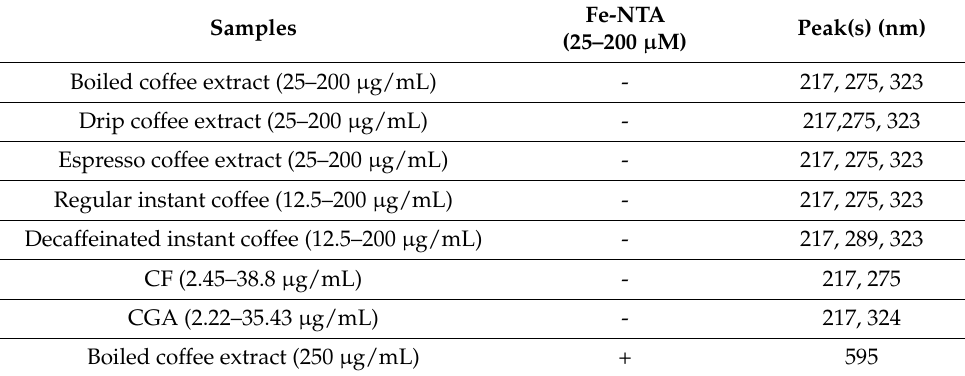
Figure 5. Spectral patterns of roasted coffee extracts, instant coffee, CF and CGA with and without the addition of iron. ( A – G ) Boiled, drip and espresso roasted coffee extracts (25–200 µ g/mL), regular and decaffeinated instant coffee (12.5–200 µ g/mL each), CF (2.45–38.8 µ g/mL) and CGA (2.22–35.43 µ g/mL) were photometrically measured at a wave- length rank of 200–800 nm against the reagent blank. ( H – N ) The coffee extracts and the instant coffees (250 µ g/mL), CF (500 µ M) and CGA (250 µ M) were incubated with Fe-NTA (25–200 µ M) for 1 h and photometrically measured at a wave- length rank of 200–800 nm against the coffee extract, instant coffee, CF and CGA solutions. Abbreviations: CF = caffeine, CGA = chlorogenic acid, Fe-NTA = ferric nitrilotriacetic acid. Table 6. Spectral peaks from roasted coffee extracts, instant coffee, CF and CGA with and without the addition of